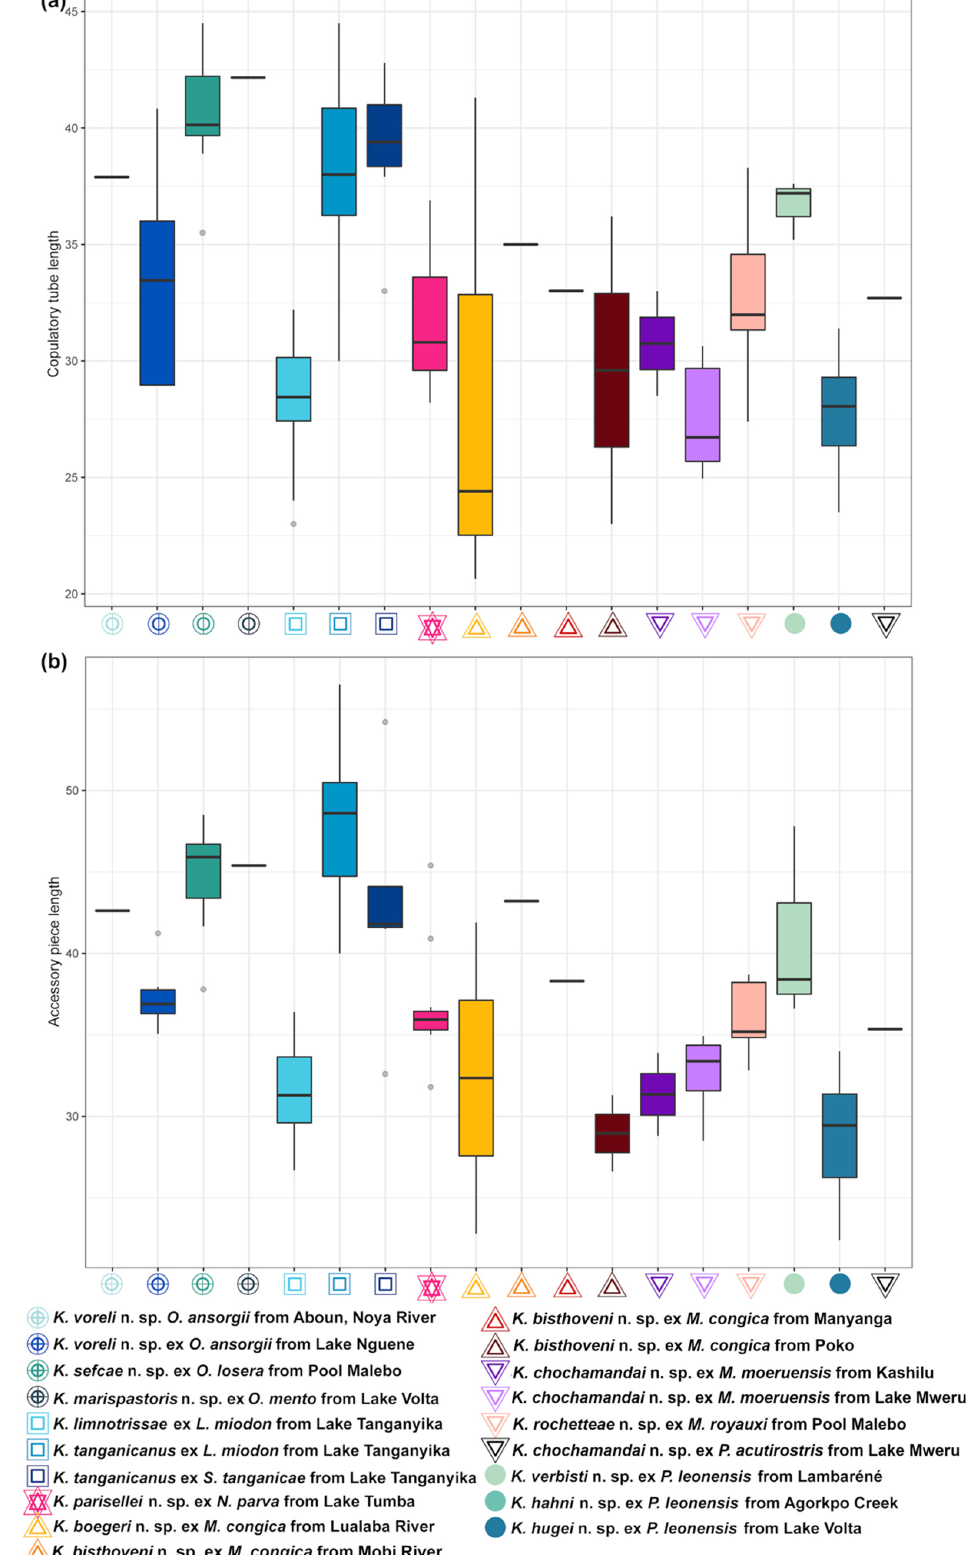
Figure 5. Morphometric variability of copulatory organ structures of Kapentagyrus spp. ( a ) Box-plot graph with copulatory tube length (y-axis in μ m). ( b ) Box-plot graph with accessory piece length (y-axis in μ m). Colours and signs denote parasite species, host species, and locality of origin.